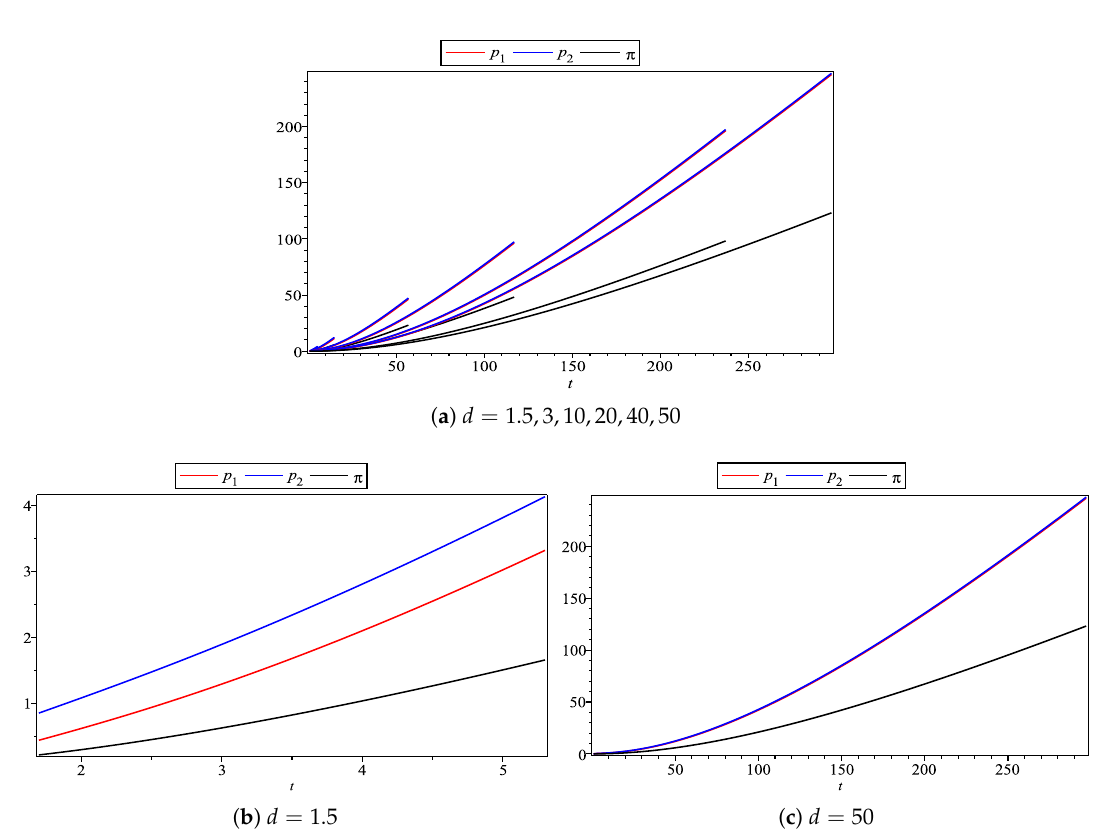
Figure 3. Subjective effect of CEA on enterprise pricing and